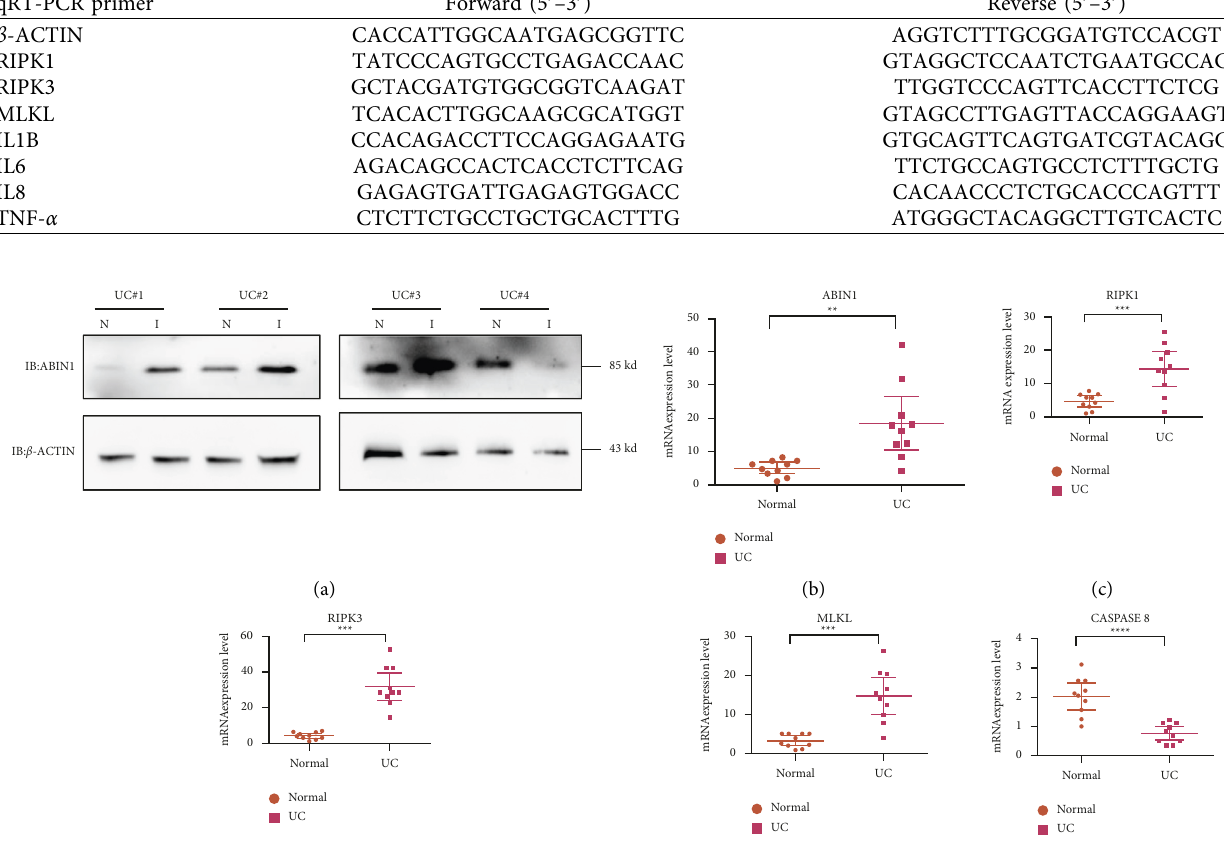
Table 1: The sequence of qRT-pcr primers.